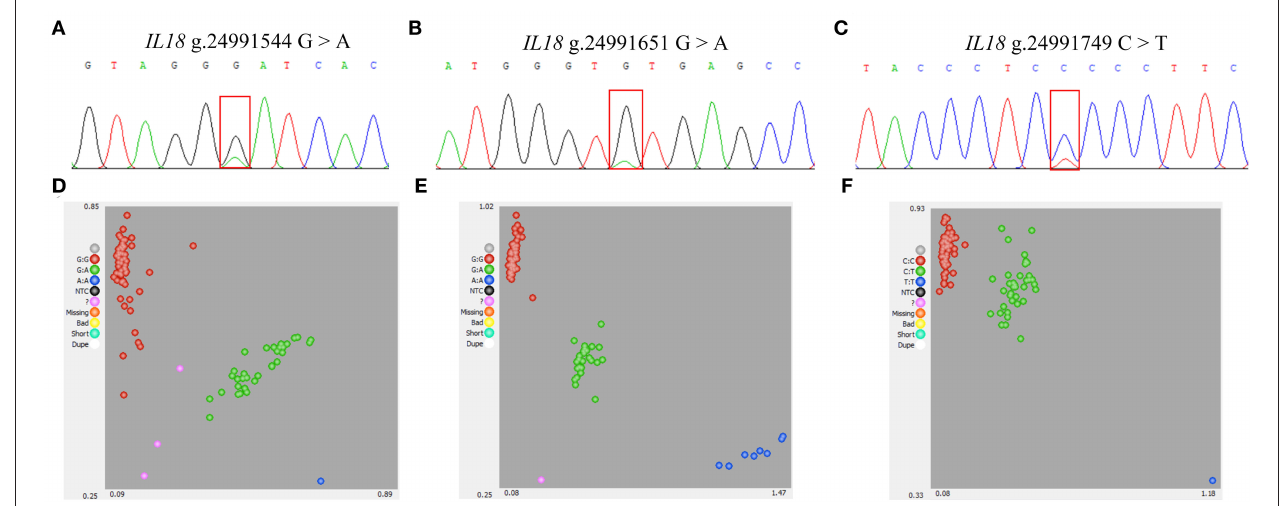
FIGURE 4 | Identification and genotyping of SNPs within ovine IL18 gene. (A–C) Sequence chromatograms of three SNPs in the sheep IL18 gene. (D–F) KASPar genotyping assay results of three positions of IL18 gene.